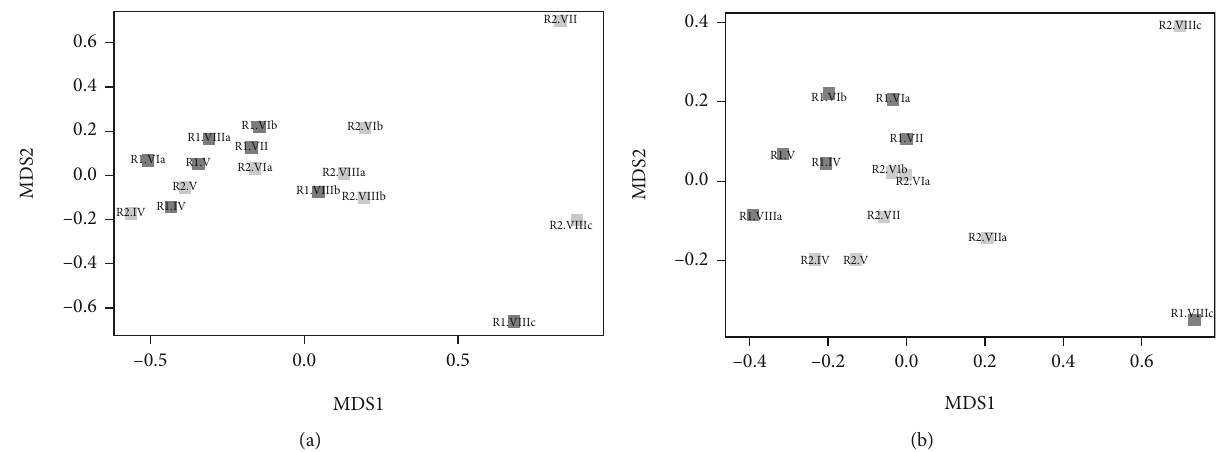
Figure 3: Nonmetric multidimensional scaling plots based on Bray – Curtis distances of the bacterial (a) and archaeal (b) communities at ASV level in R1 (light grey) and in R2 (dark